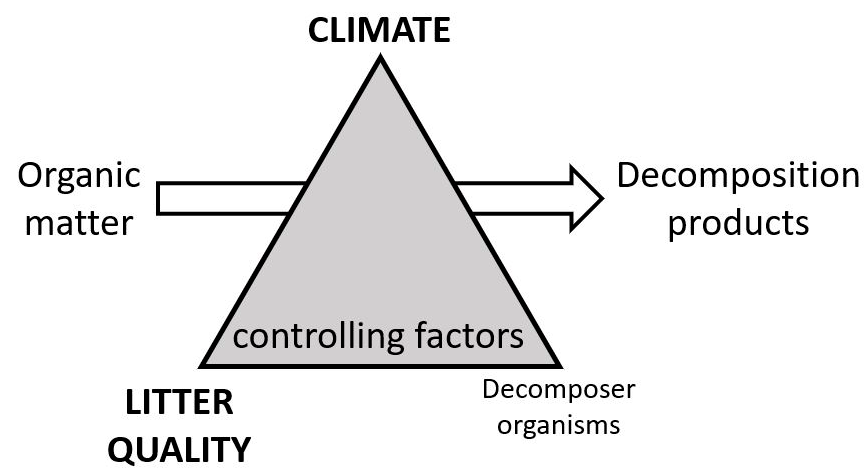
Figure 2. The decomposition triangle is the classical conceptualization of the dominant factors regulating litter decomposition rates, which is modified here to represent the contemporary paradigms. The decomposer organisms are shown in small font to emphasize that under contemporary paradigms, climate and litter quality are considered to be the dominant factors regulating the rate at which organic matter decomposes. Modified from Bradford et al. [23].